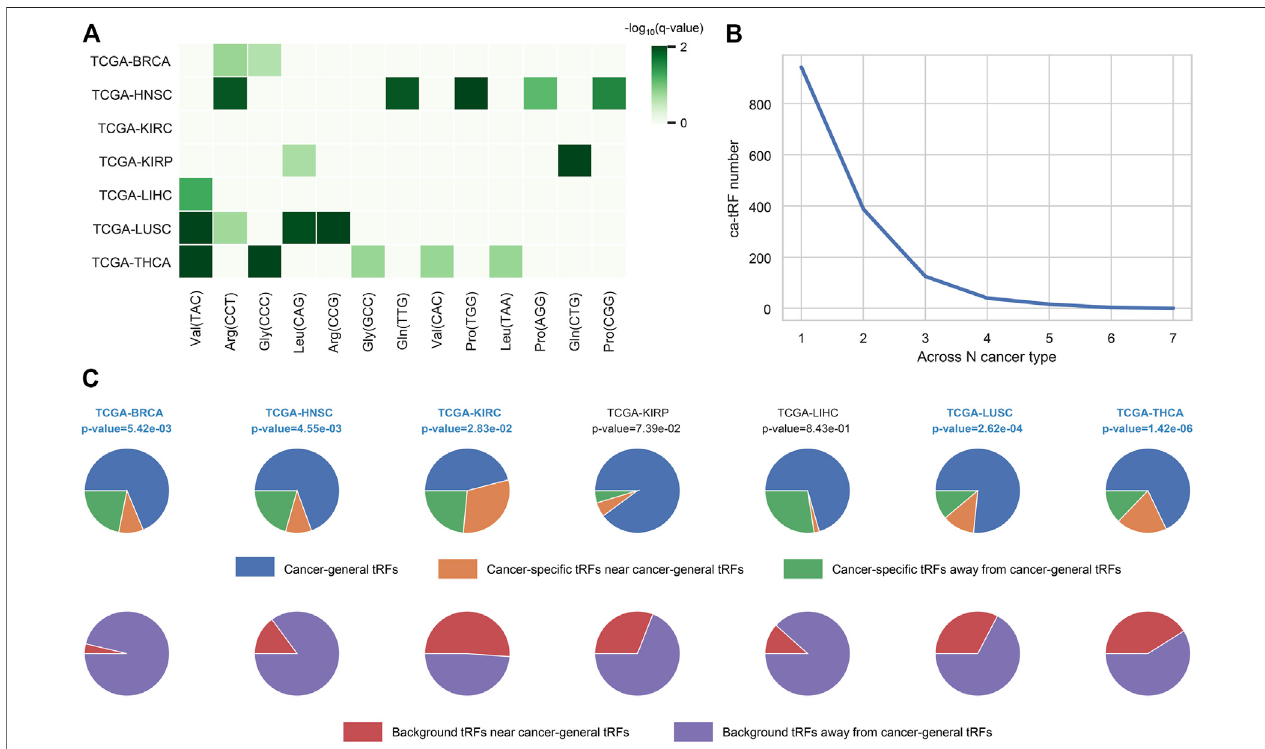
FIGURE 3 | Overview of ca-tRF distribution. (A) The major parental tRNA isoacceptors of ca-tRFs of each cancer type. (B) The distribution of associated cancer type number among ca-tRFs. (C) The proportions of the cancer-general ca-tRFs (blue), the cancer-speci fi c ca-tRFs near the general ca-tRFs (yellow) and the cancer- speci fi cca-tRFsawayfromthegeneralca-tRFs(blue).Forcomparison,thepiechartsdepictingtheproportionsofbackgroundtRFsnear(red)andfarawayfrom(purple) thegeneralca-tRFsarealsoshownbelow.Herethe “ near ” and “ awayfrom ” arede fi nedbywhetherthetwocomparedtRFsarestaggeredwitheachothernomore than ormore than 2 ntintheir parental tRNA,respectively.The statisticalsigni fi canceabout whetherthecancer-speci fi cca-tRFs aretending near tothe generalca-tRFs than the background was measured by Fisher ’ s exact test and the signi fi cant cancer types were highlighted with blue and bold font.